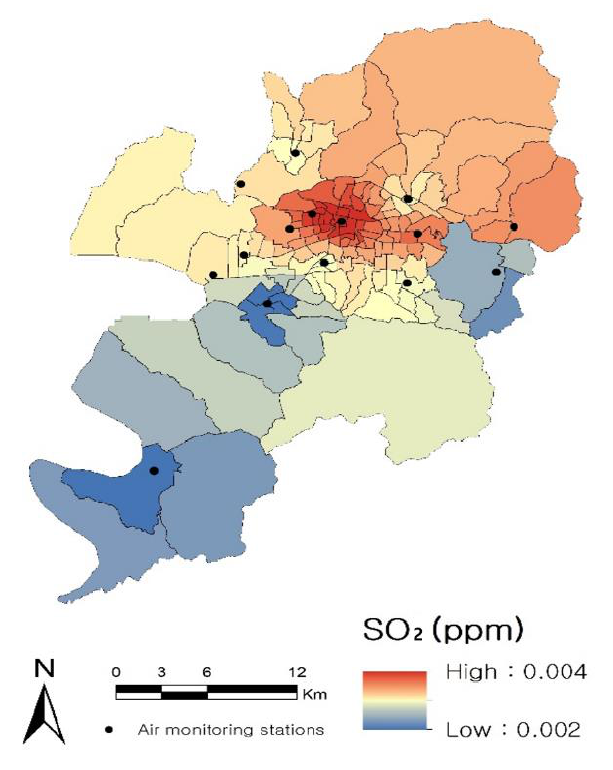
Figure 6. Spatial distribution of SO 2.